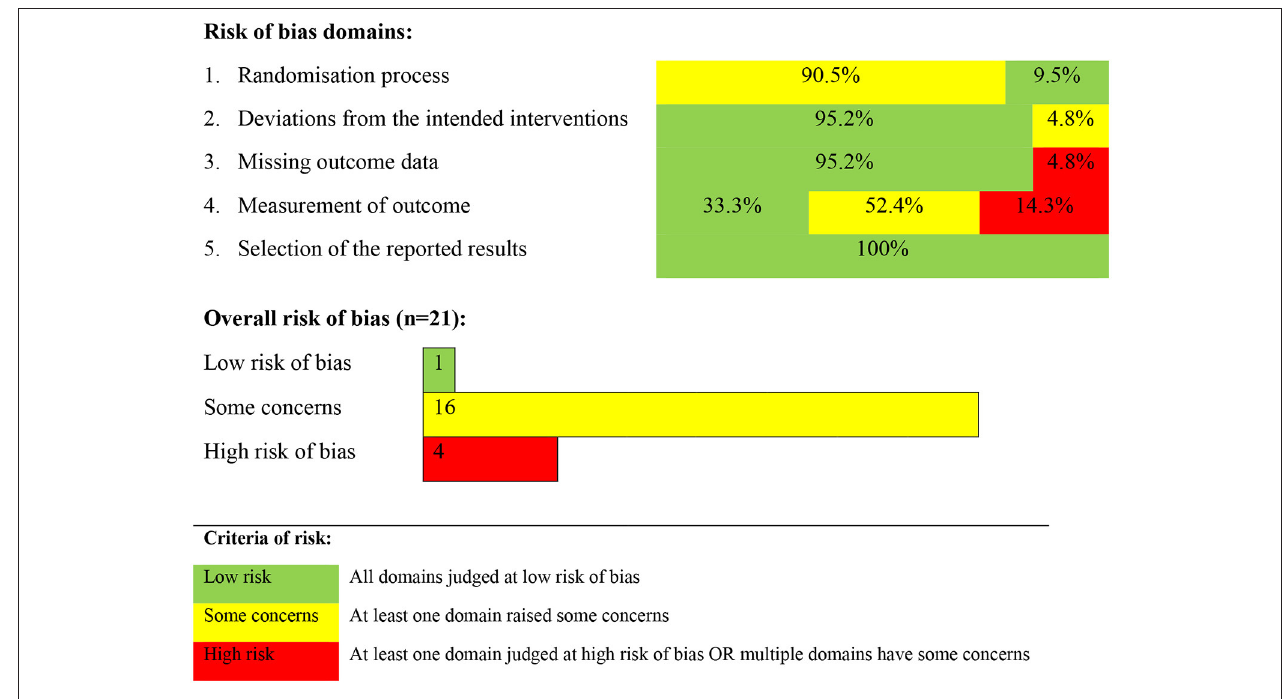
FIGURE 2 | Risk of bias criteria for the literature